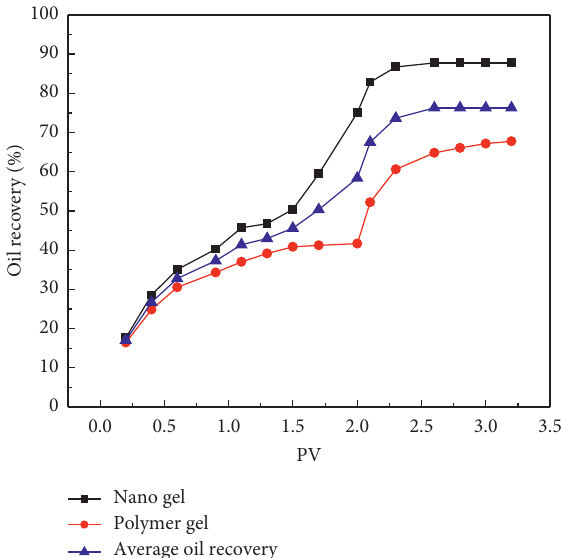
Figure 6: Cumulative oil recovery of polymer gel and nanosuspensions